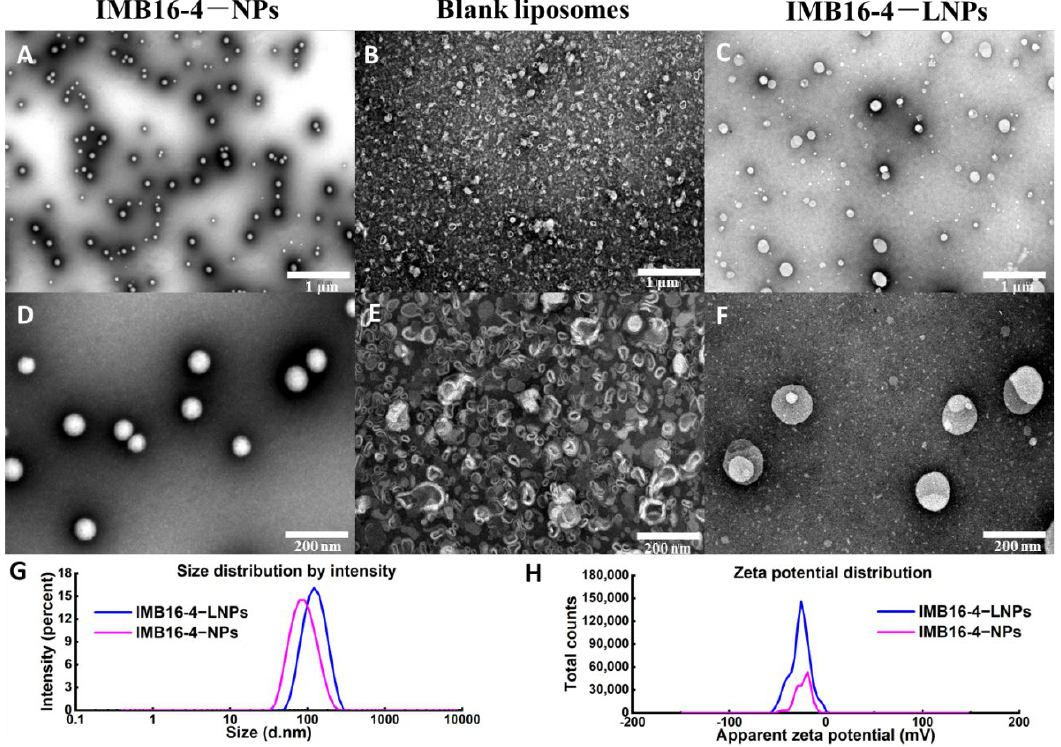
Figure 1. TEM of IMB16-4 − LNPs fabricated by coating bilayer lipid membrane to IMB16-4 − NPs. ( A , D ) IMB16-4 − NPs. ( B , E ) Blank liposome. ( C , F ) IMB16-4 − LNPs. ( G ) Particle size and ( H ) Zeta potential of IMB16-4 − NPs and IMB16-4 −